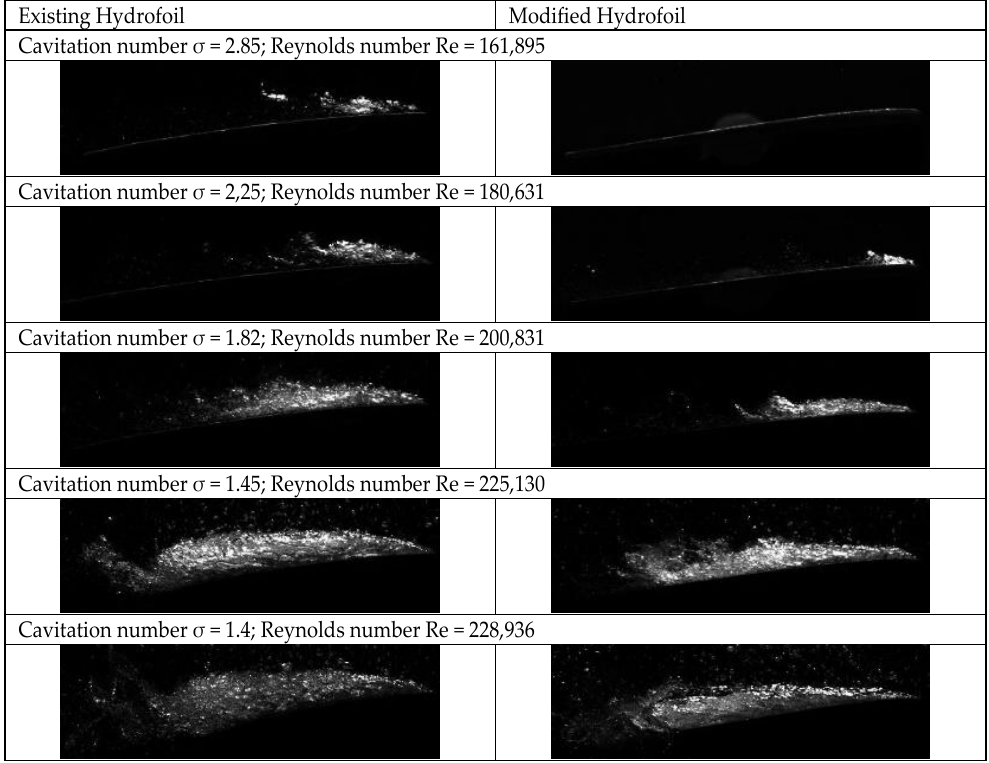
Figure 13. Visualization results of cavitation structures at p abs = 0.15 bar.